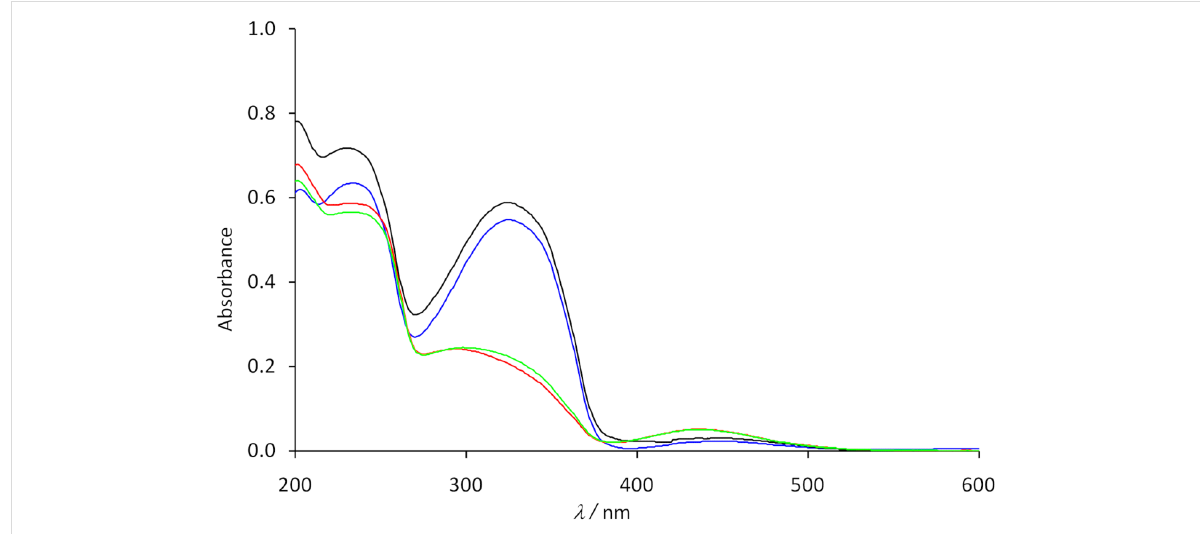
Figure 4: UV spectra of the foldable container 10 in acetonitrile after synthesis (blue), after irradiation with light of the wavelength λ = 365 nm (red), after irradiation with light of the wavelength λ = 405 nm (black) and after irradiation with light of the wavelength λ = 365 nm (green).